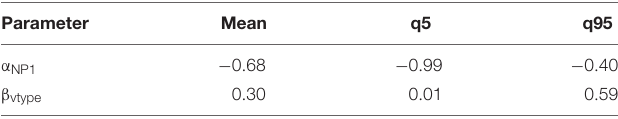
TABLE 1 | Mean estimate and credible interval for the parameters of the Expectancy model, Experiment 1. Parameter